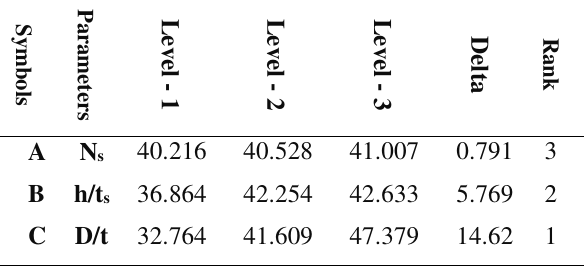
Analysis of mean results based on S/N